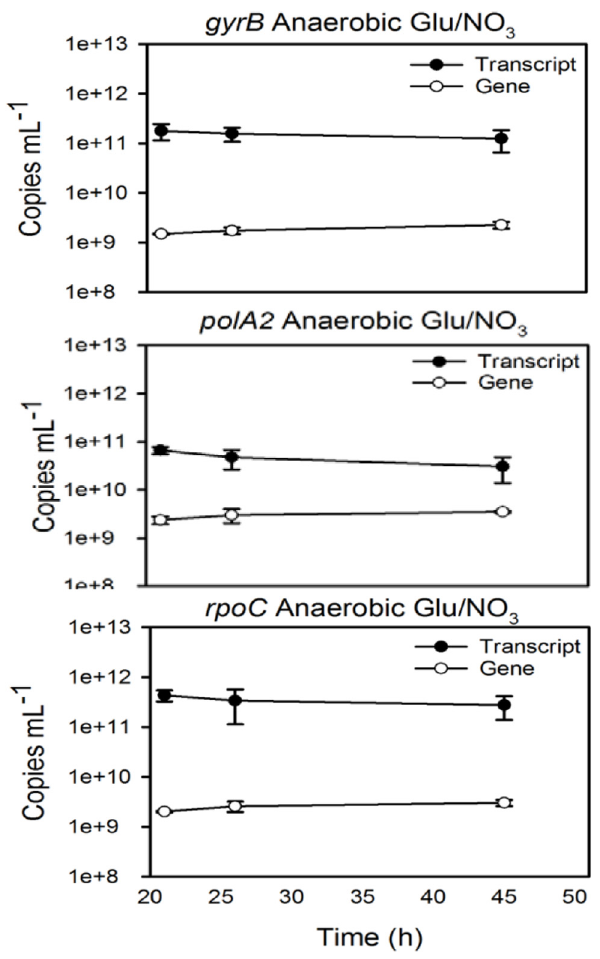
Fig 2. Representative figure of data used to obtain transcript-to-gene ratios for gyrB , polA2 , and rpoC . Samples were collected at multiple time points from anaerobic cultures supplemented with glucose as the carbon source and nitrate as the terminal electron acceptor. Transcript and gene copies per mL of sample were calculated via absolute quantification using external calibration curves. Error bars represent the standard deviation derived from triplicate qPCRs from three biological